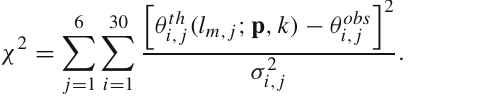
Fig. 2 Distribution of k parameter in our sample. Blue solid curve rep- resentsthebestfittedcontinuousdistributionfunction.Puresynchrotron self-absorption case ( k = 1) is denoted by the purple dashed line